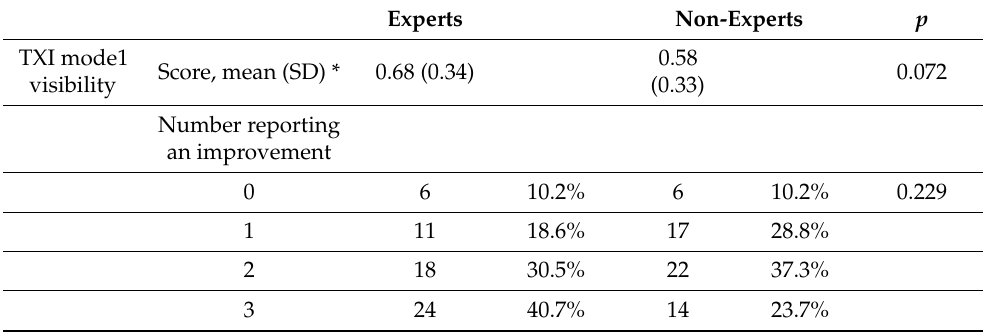
Values are presented as mean (SD). * Wilcoxon signed-rank sum test.